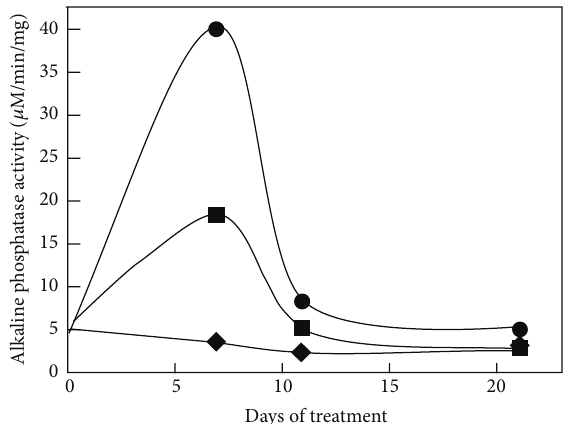
Figure 3: Effect of the recombinant mature domain of Pf BMP-2 and the synthetic polypeptide of the knuckle epitope of human BMP-2 treatment on the endogenous expression of alkaline phosphatase in C3H10T1/2 cells. C3H10T1/2 cells were plated into 48-well tissue culture dishes for 2 days followed by incubation with the recombinant mature BMP-2 and the synthetic polypeptide of the Knuckle epitope of human BMP-2 at a final concentration of 5 𝜇 g/well and 80 𝜇 g/well, respectively. At 7, 11, and 21 days, alkaline phosphatase expression was measured, as indicated. (cid:2) - (cid:2) : Pf BMP-2; ◼ - ◼ : the Knuckle epitope of human BMP-2 synthetic polypeptide; ⧫ - ⧫ : in the absence of protein.